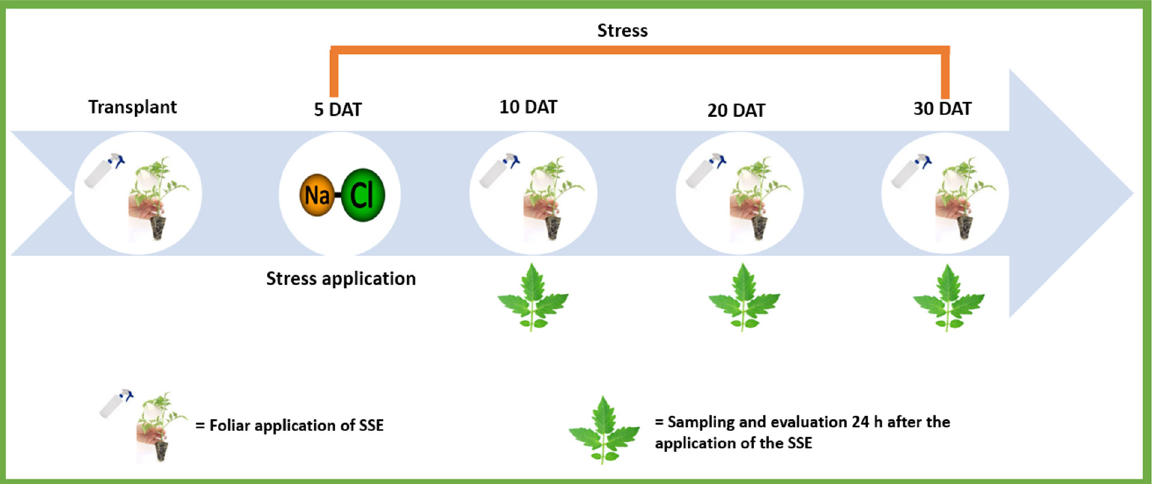
Figure 8. Schematic representation of the experiment. SSE: Sargassum spp. seaweed extracts; DAT: Days after transplant.